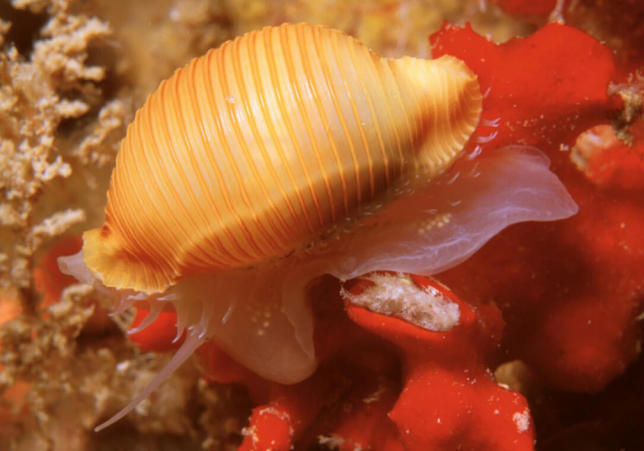
The charismatic cowrie